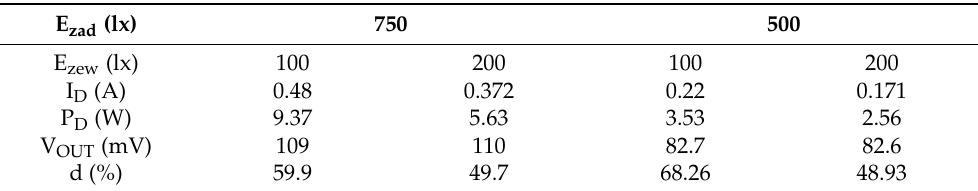
Table 5. Values of electrical and optical parameters for selected values of external illuminance for the system with the Ring XRE module.